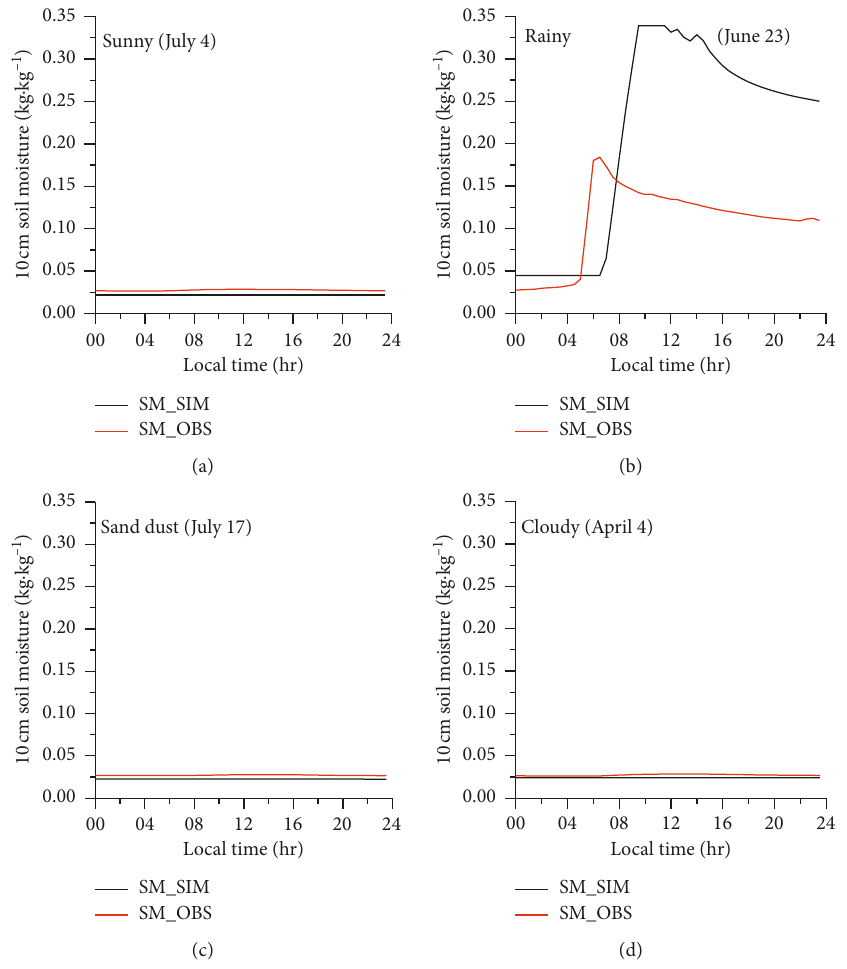
Figure 4: Contrast curve between the simulated (black) and observed (red) soil moisture (SM) for soil at a depth of 10 cm in the four types of weather at the Tazhong station in 2014.